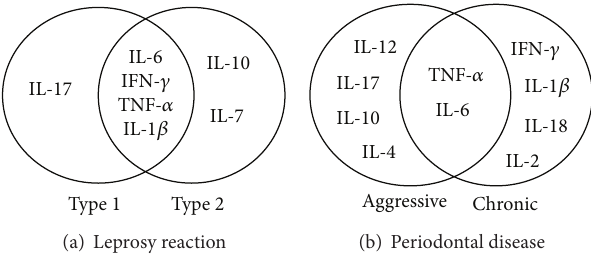
Figure 3: Main serum inflammatory mediators that were identified in leprosy reactions and periodontal diseases, by type, in the articles published between January 1, 1996, and December 31, 2013, that were selected for the systematic